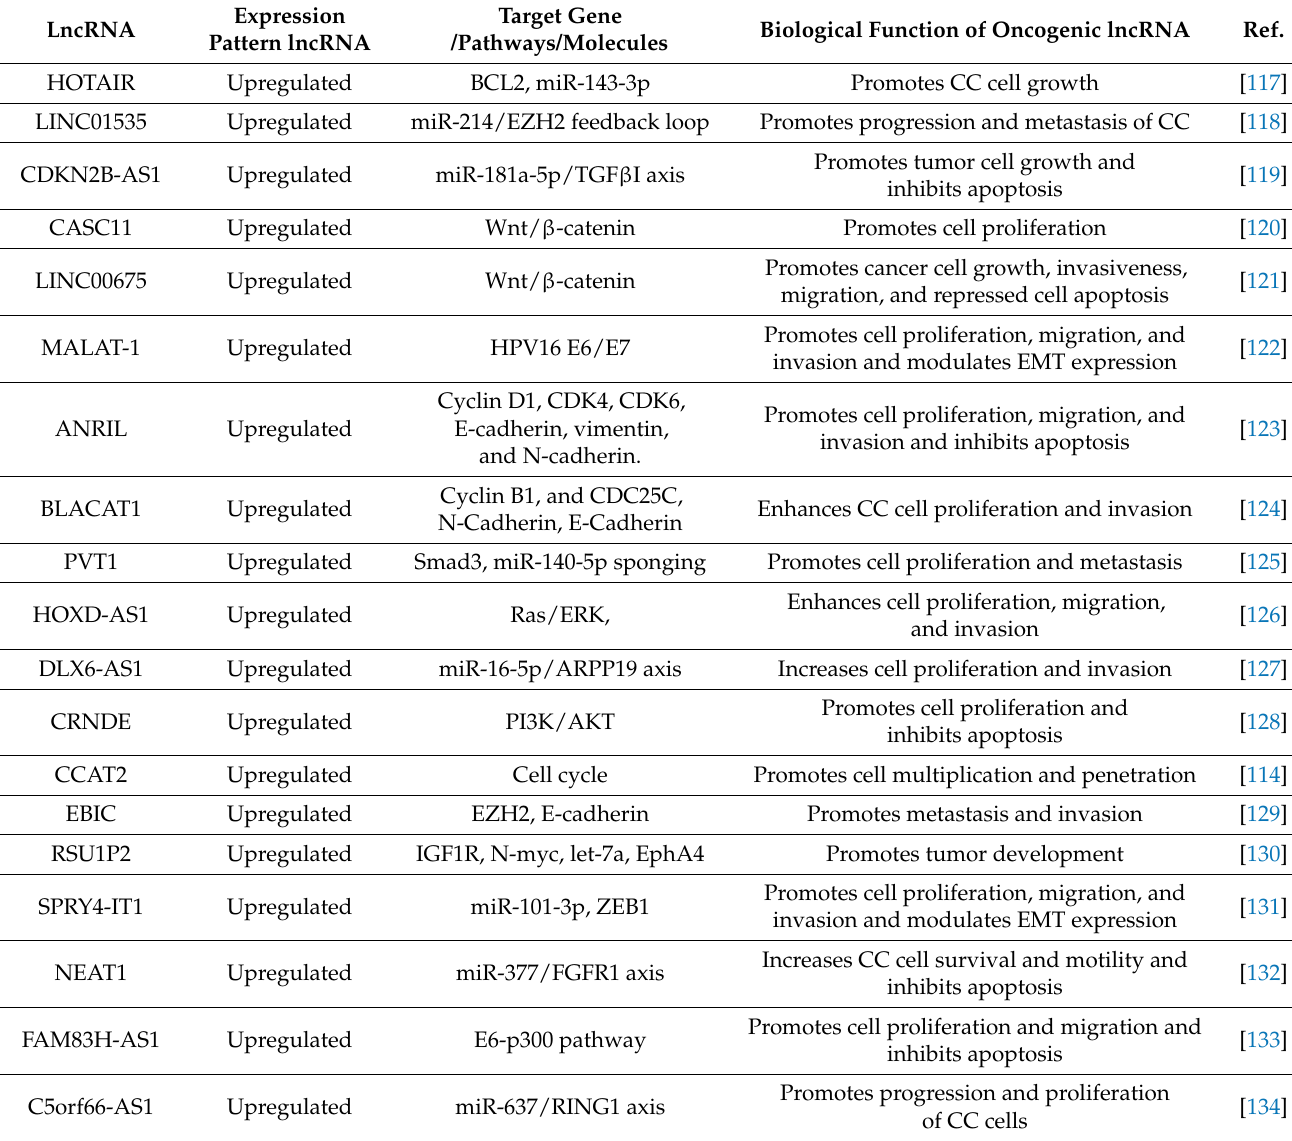
Table 3. Summary of selected oncogenic LncRNAs with their functional effects in